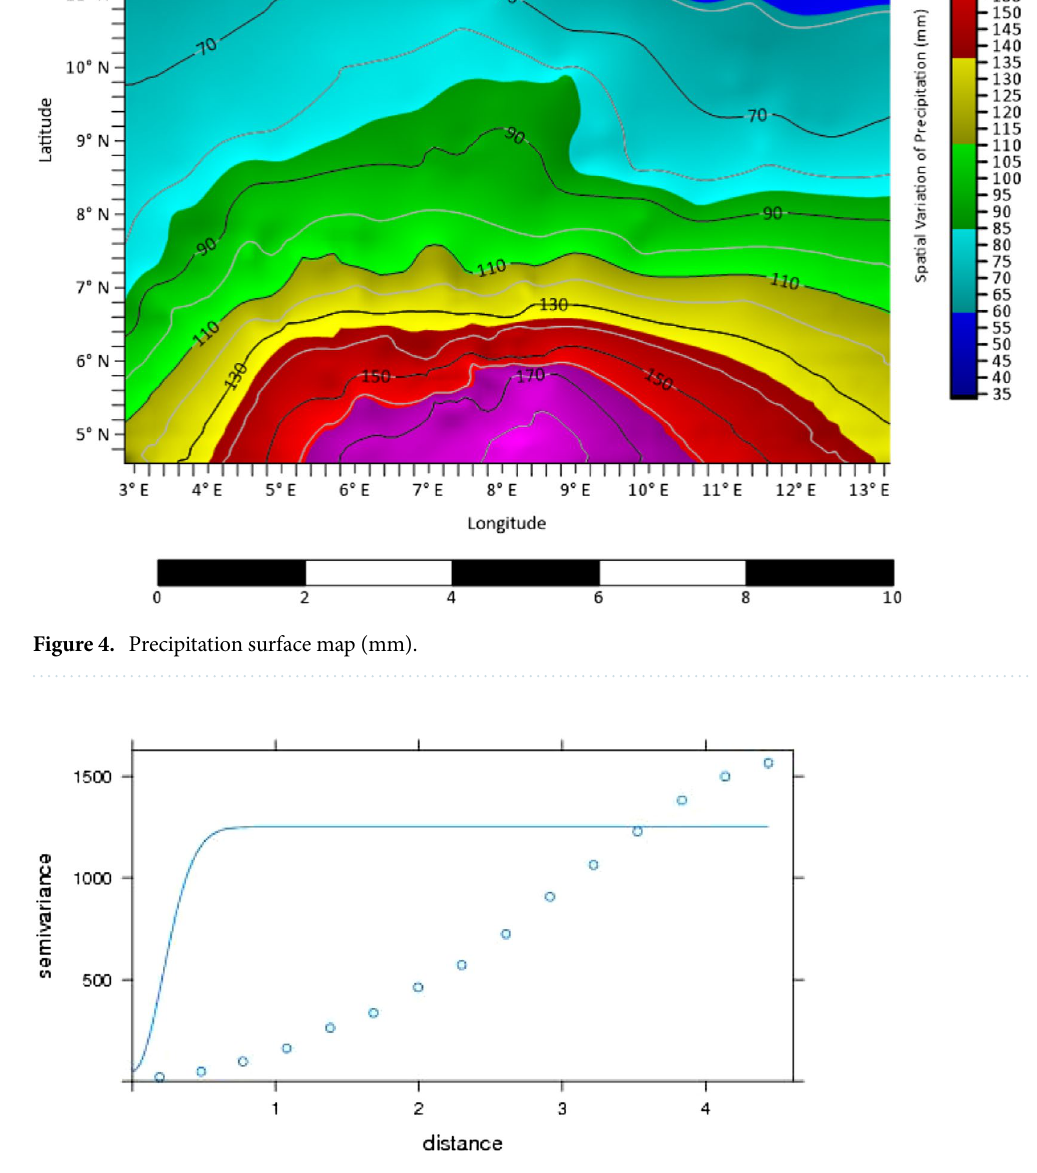
Figure 5. Variogram plot for precipitation 29